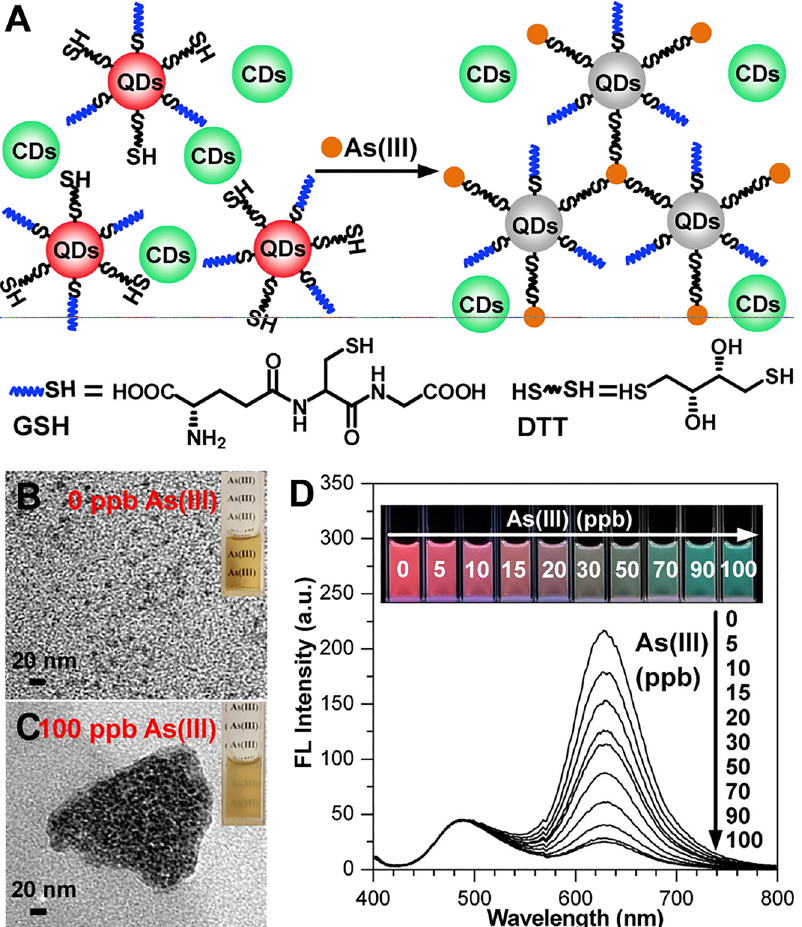
Figure 6: Schematic illustration of fluorescence paper strips for